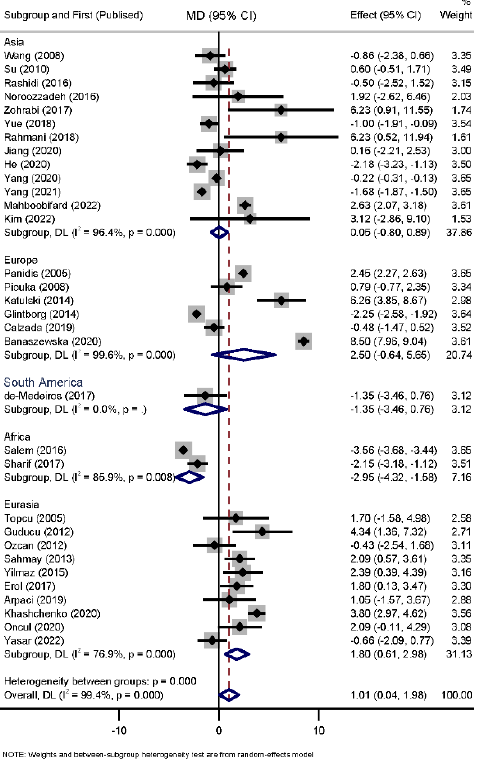
Figure 3. Sub-grouped meta-analysis of 32 comparisons reporting on PRL in PCOS participants compared with non-PCOSs by continent. [9,13–20,24–46].